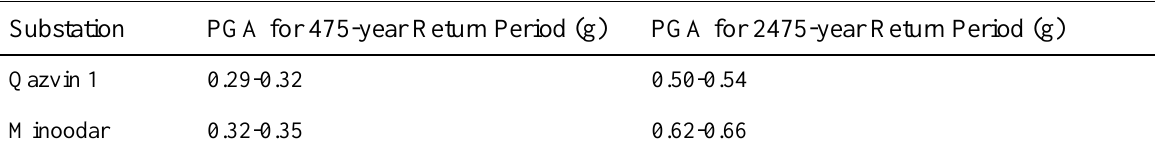
Figure 10. (a) Peak Ground Acceleration (PGA) for 475-year return period for Qazvin, (b) Peak Ground Acceleration (PGA) for 2475-year return period for Qazvin (Azizi, 2009) Table 5. Peak Ground Acceleration (PGA) for two return periods in the location of power substations (Azizi, 2009)